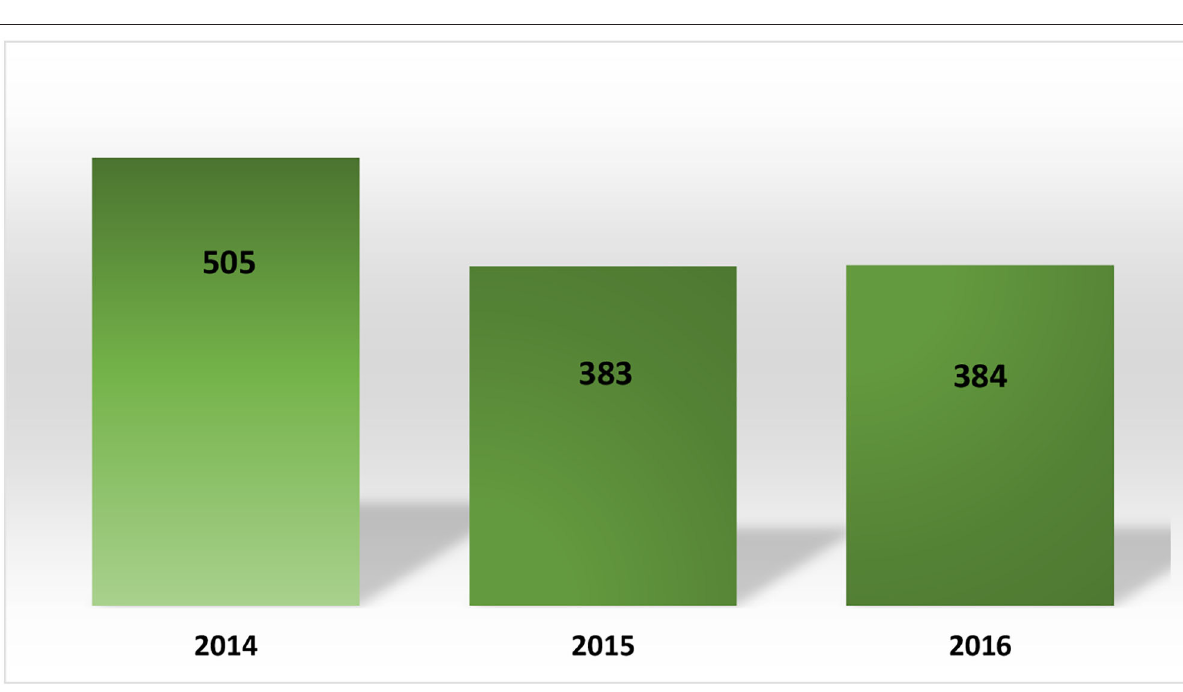
FIGURE 3 | Post-approval changes processed in Mexico